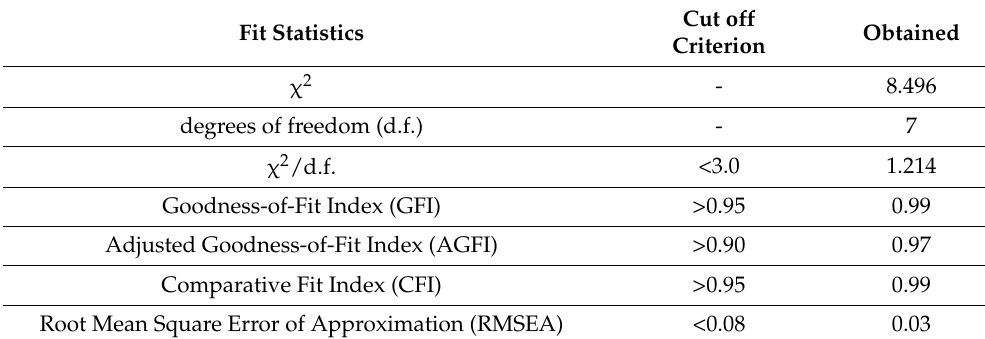
Table 3. GoF measures of the SEM reflective model. Fit Statistics